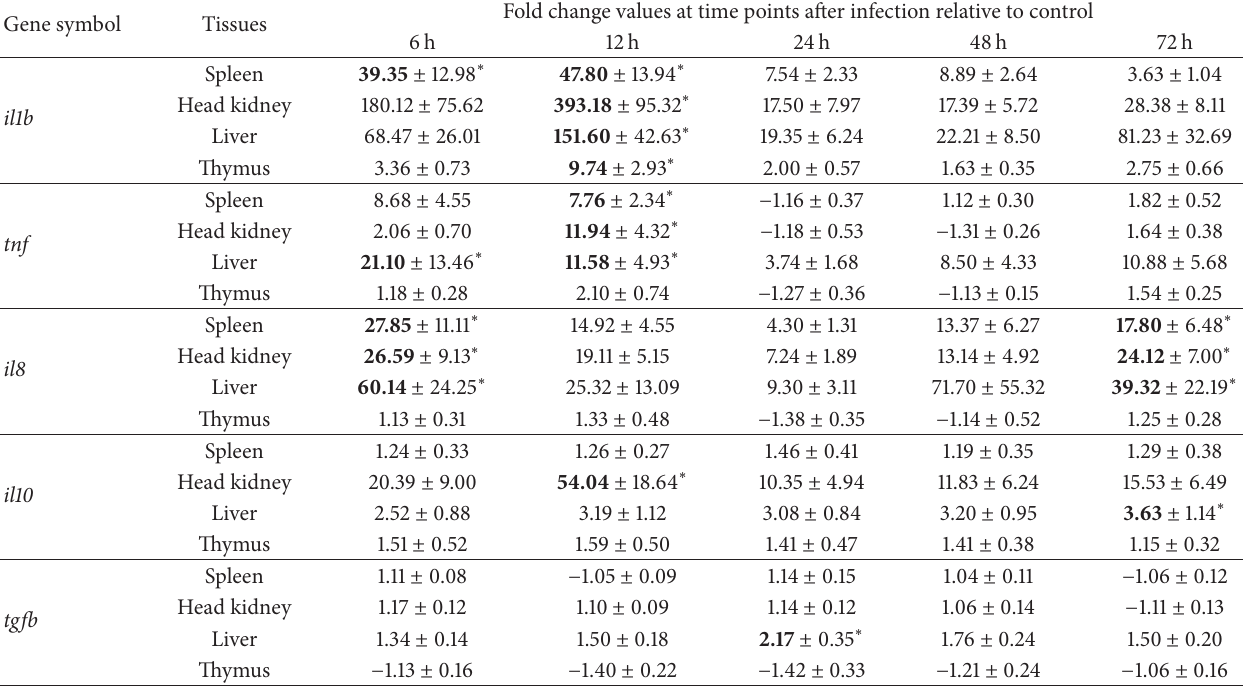
Table 2: Expression profiles of various cytokines in selected tissues of rainbow trout at different time points after infection. Gene